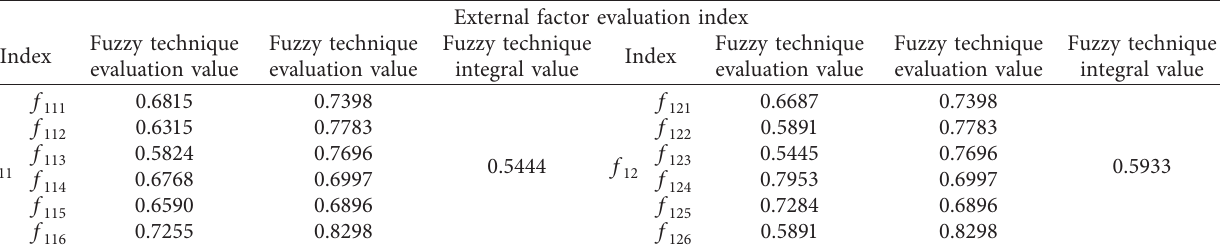
Table 6: ARR advance intelligent manufacturing-emerging strategic path four-level index and fuzzy technique integral